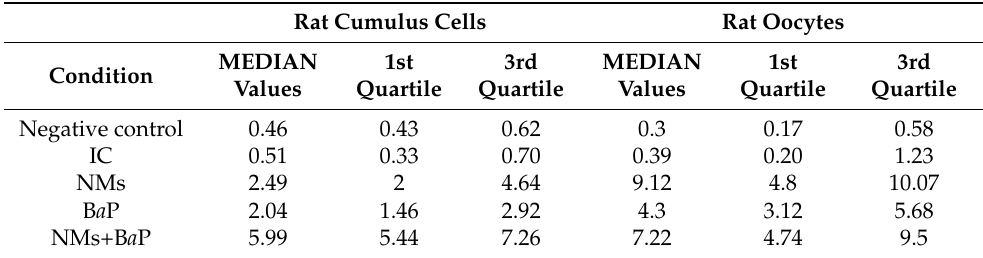
Table 2. Median values of % olive tail moment (OTM) of each condition of three experiments, with 1 ◦ and 3 ◦ quartiles, in cumulus–oocytes complexes